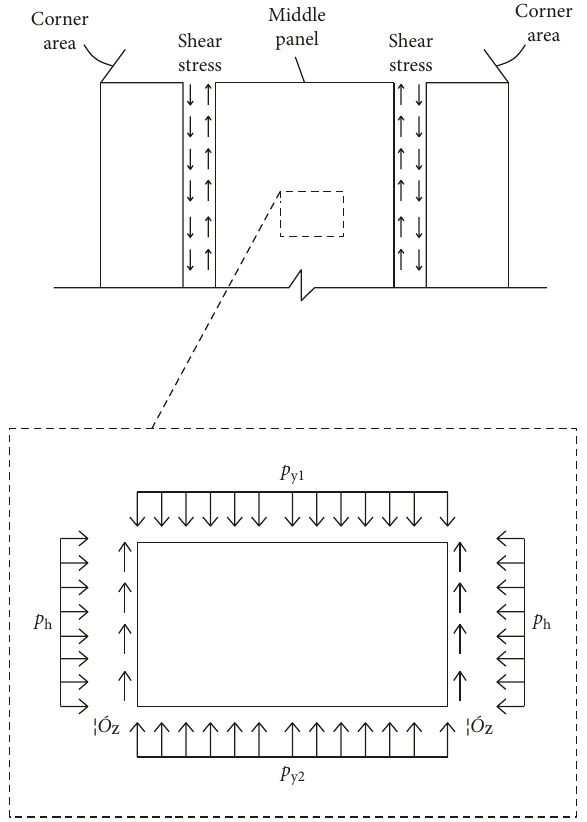
Figure 16: Internal force distribution between steel tube plates and steel corner